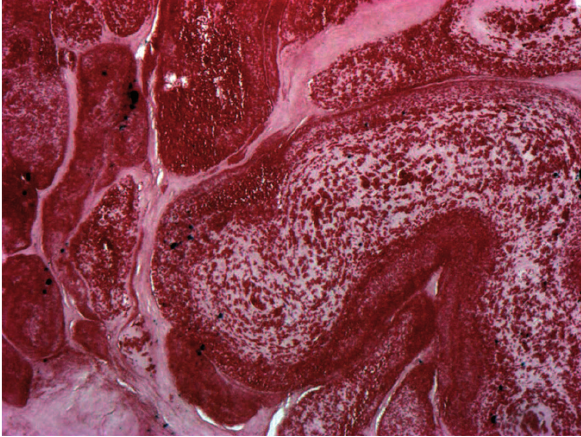
Fig. 2 – Endothelium-coated tumor rich in extracellular matrix, collagen and elastin, both muscle cells and elastic fibers (orcein 10x magnification)